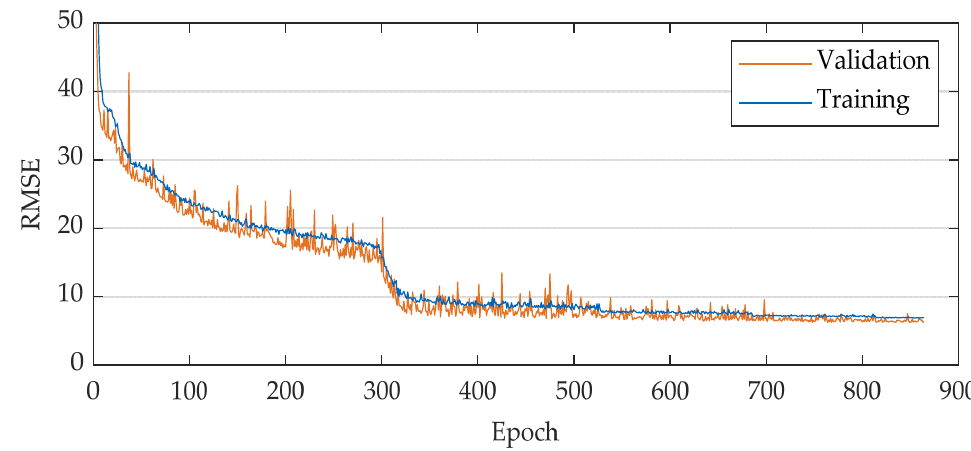
Figure 12. Training and validation loss of the BPNN during training for Use Case 2.